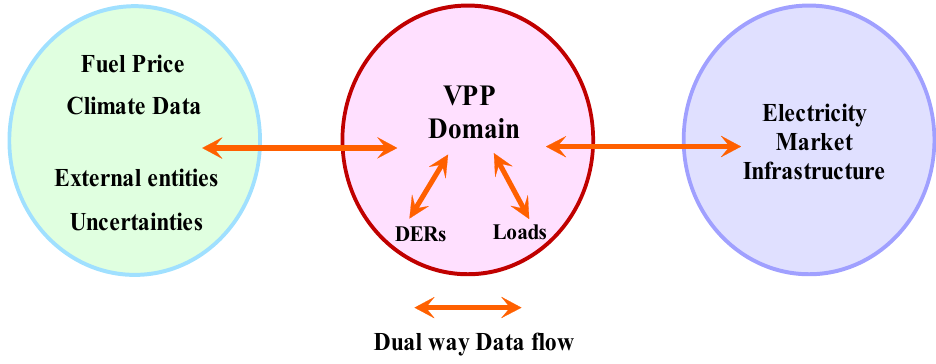
Figure 1. The Framework of a VPP.